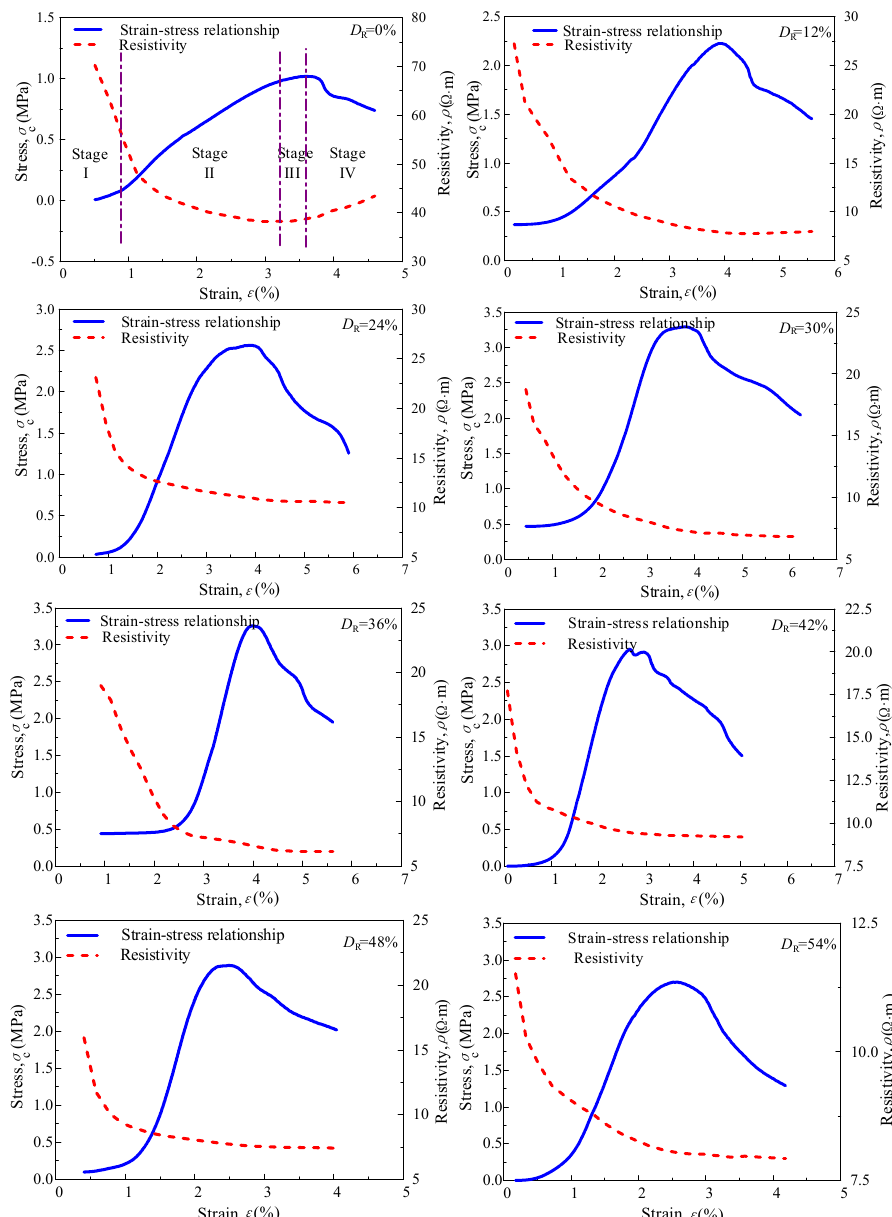
Figure 21. Curves of stress–strain–electrical resistivity with curing age of 14 d . Note that trends of resistivity of RMLS mixture ( D R > 0) in elastic and strengthening stages are similar with loessial silt. However, there is no increase of resistivity of RMLS mixture after failure of the sample (in stage III) and the resistivity tends to be a constant value, which is different from loessial silt. Hydration reaction of red mud could explain this result: new cementitious substances generated from red mud connect with soil particles to form a silk and mesh structure. This new stable structure decreases the likelihood of brittle failure for RMLS mixture and the damage form is changed to plastic failure